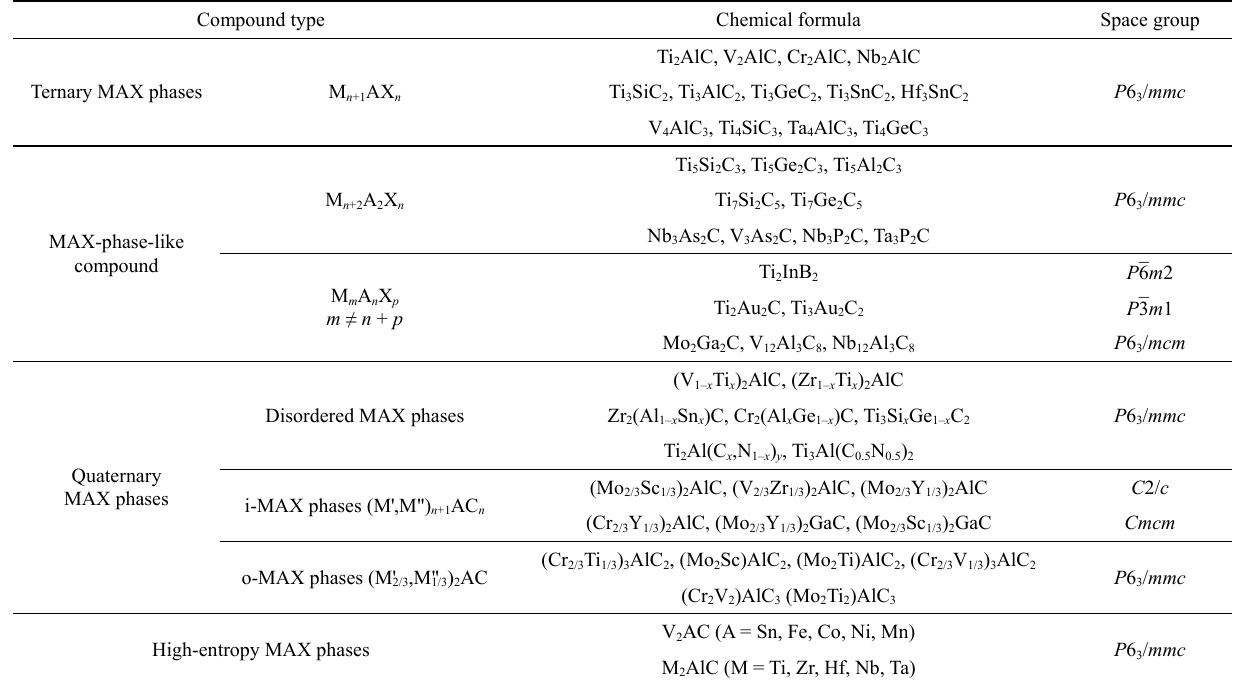
Table 1 Crystal structures of some typical MAX phases and MAX-phase-like compounds